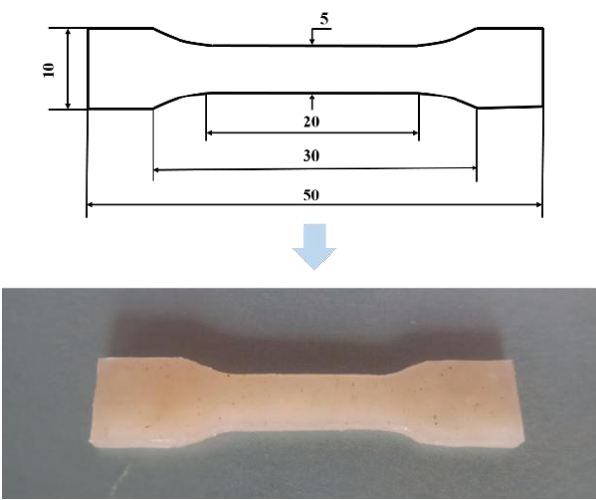
Figure 3. Shape and dimensions of a standard tensile spline.